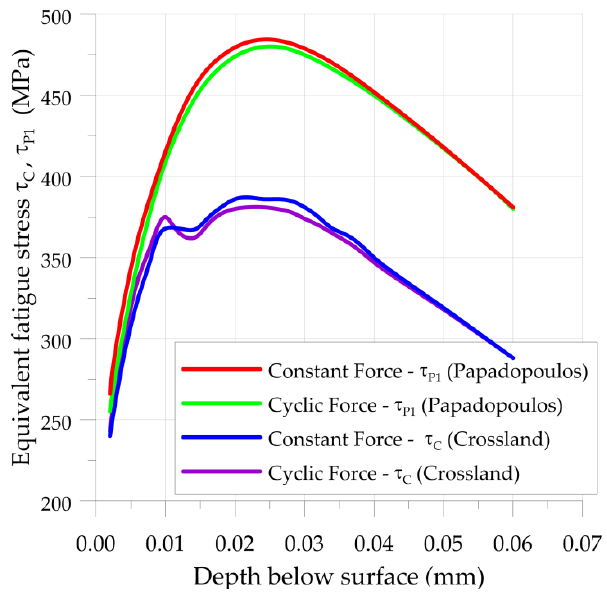
Figure 5. Fatigue stresses on different depths, calculated by Crossland and Papadopoulos criteria; K81102TN roller bearing subjected to constant and cyclic force. K81102TN roller bearing subjected to constant and cyclic